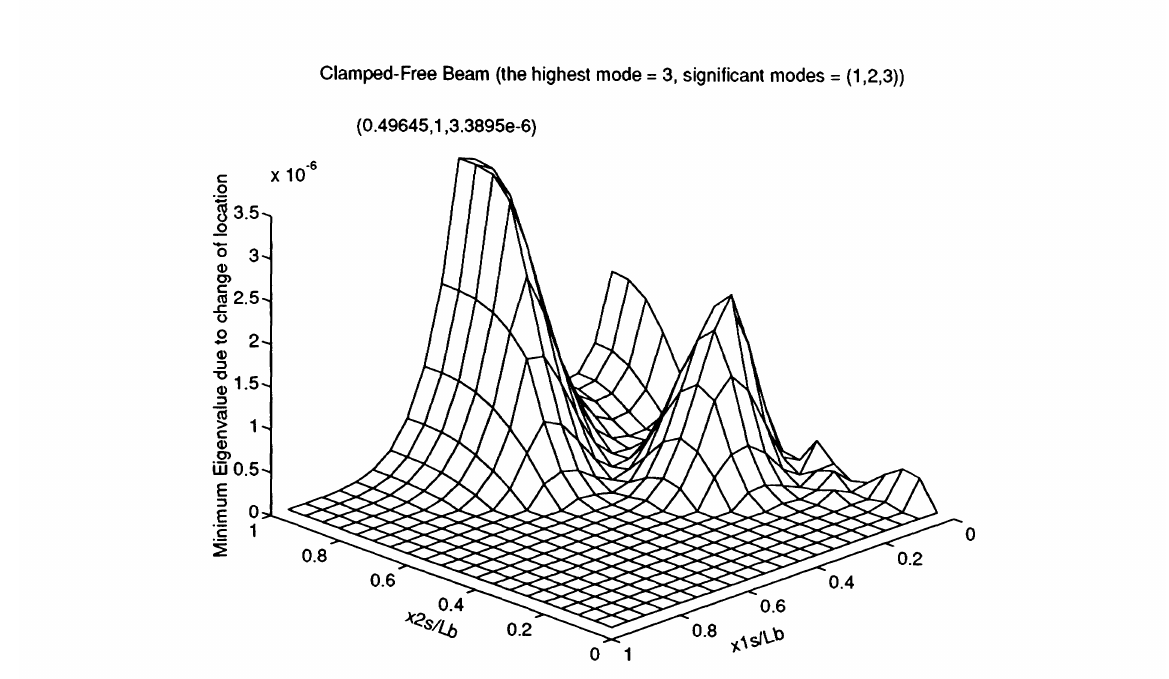
FIGURE 14 Minimum eigenvalue of W~ in clamped-free